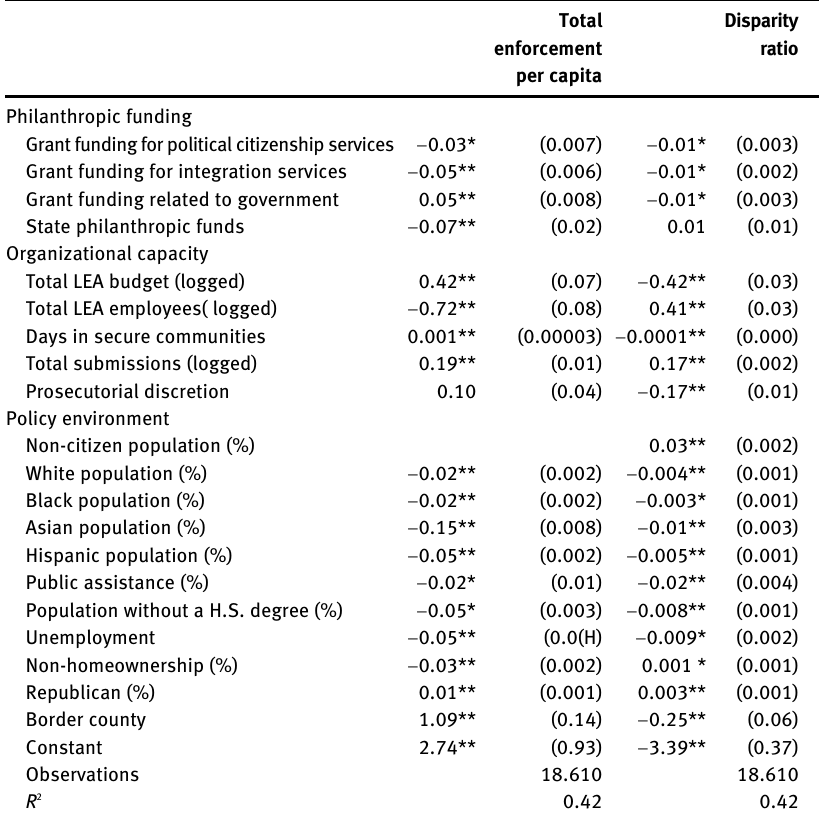
Table  : Theeffectofphilanthropicfundingbypolicygrantactivityonimmigrationpolicyoutputs.